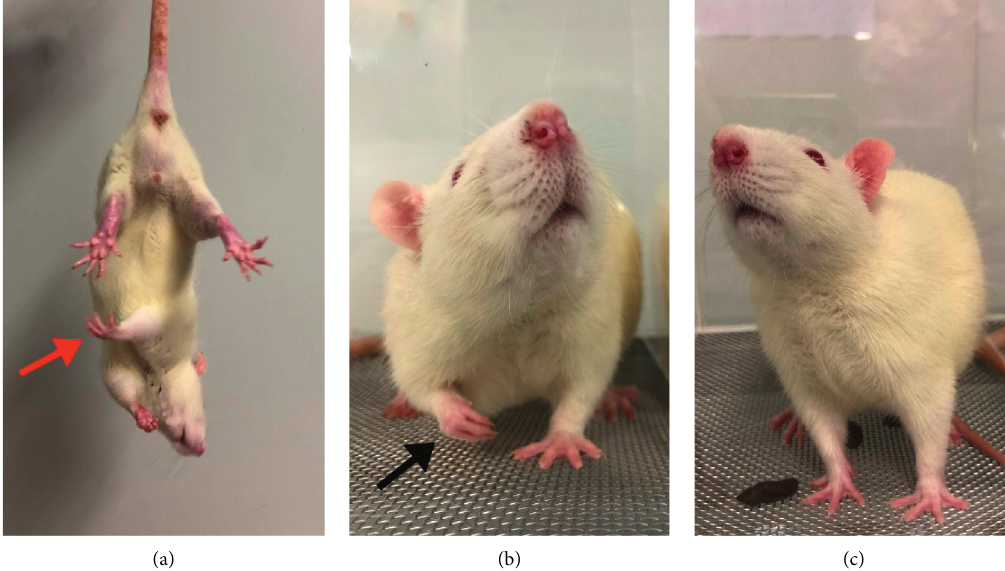
Figure 4: Affected forepaw posture. (a) Thirty days after the MCAO procedure, the rats still could not fully extend the affected forepaw (red arrow). (b) Rats often raised the affected forepaw (black arrow) from the floor and held it when standing or sitting. (c) The abnormal postures caused by C7 neurotomy lasted for approximately one week, but not